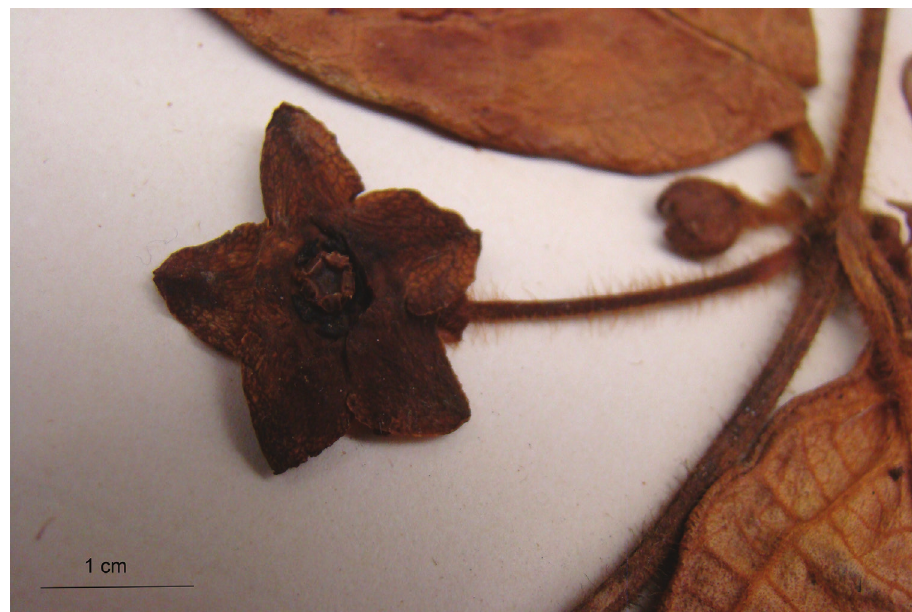
Figure 1. Flower of Phaeostemma fucata (from Steyermark 59963 , MO).